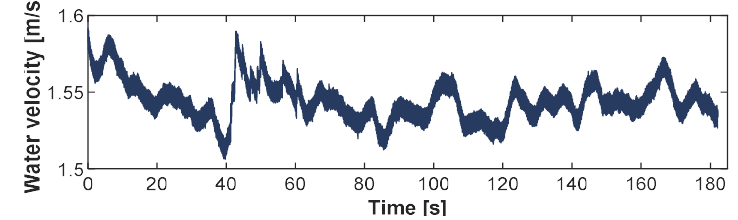
Figure 11. Adopted turbulent water velocity.